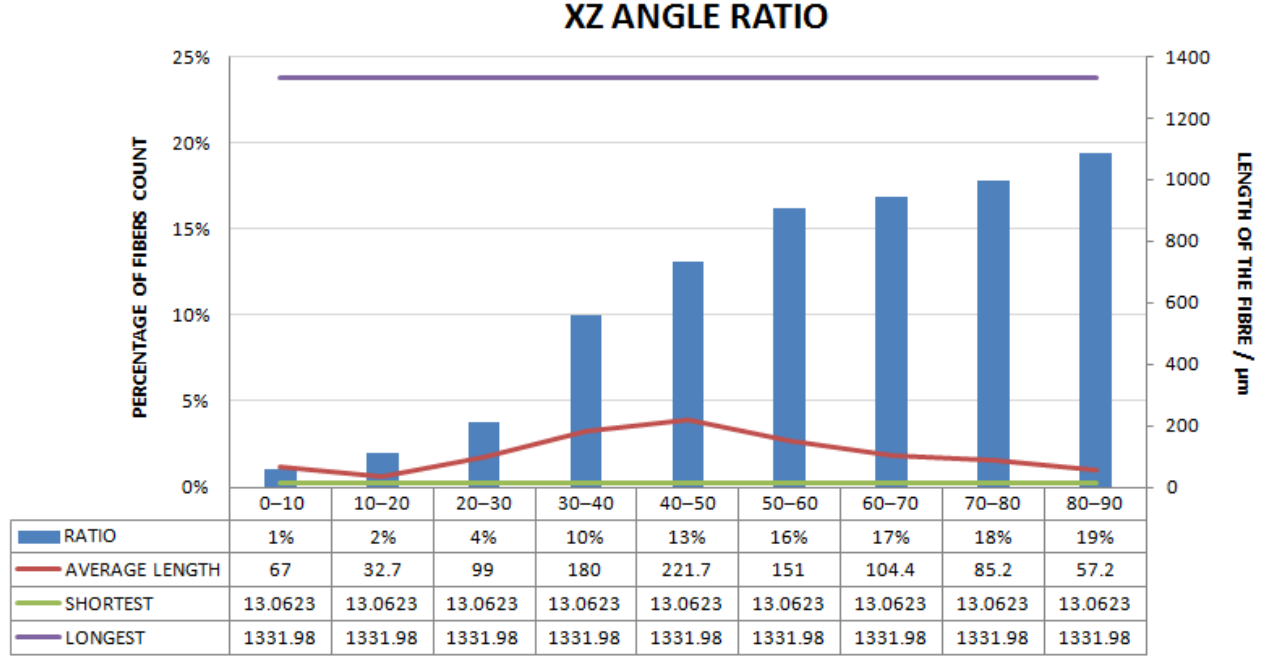
Figure 22. Statistical diagram of the angle between polyester short fibers reconstructed by Avizo software and the XZ direction.